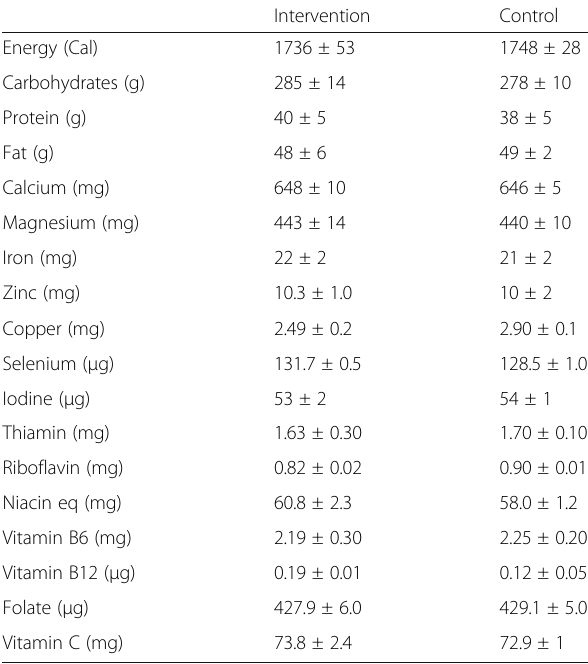
Table 4 Mean dietary intake of subjects during intervention and control